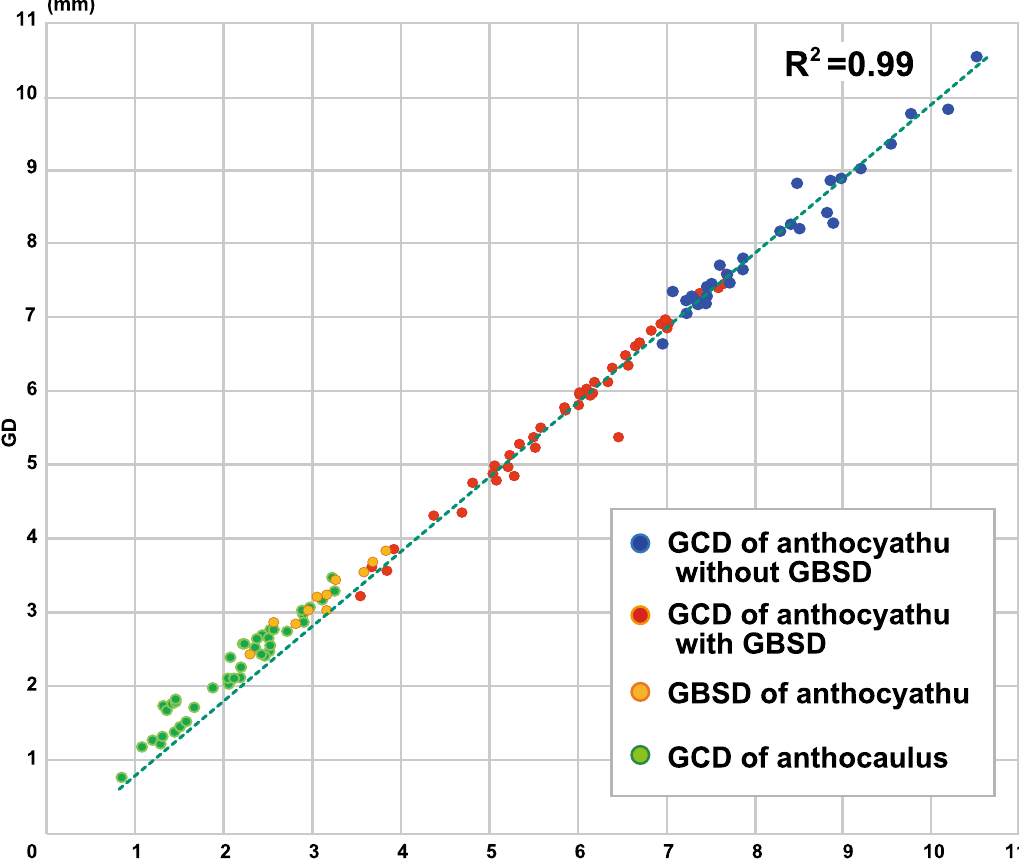
Figure 5. Relationship between the GCD/LCD of Anthocyathu without GBSD, GCD/LCD of Anthocyathu with GBSD, GBSD/LBSD of Anthocyathu and GCD/LCD of Anthocaulus (R2 = 0.99, N = anthocyathus without it (Fig. 3, Supplementary Table S1). In addition, Sentoku et al . 8 showed that D. orientalis is capable of self-repair if 10% of the skeleton remains after physical damage, in which the basal discoloration can potentially be lost. Therefore, discoloration restricted to the basal part of D. orientalis is inferred to be generated by decalcification, and almost all D. orientalis may inherently have a discolored basal part. In the attached specimens, white opaque discoloration lines on the outside of the wall perpendicular to the growth direction and double-walled structures, such as rejuvenescences, were observed (Fig. 4A–C). Anthocauli of Pliocene fossils of Truncatoflabellum carinatum and extant Truncatoflabellum spp. show successive rejuve- nescences that are derived from a temporal decrease in polyp diameter due to transverse division injury 14,15 . Moreover, the anthocauli of extant Truncatoflabellum spp. exhibit traces of decalcification at the uppermost periphery of the outer wall portion of the rejuvenescence. A similar trace of decalcification of anthocaulus has been reported in Fungia fungites 16 . The discoloration and double-walled structures in the attached specimens are thought to have been formed by transverse division with decalcification. Furthermore, the nucleotide sequences of the undescribed species and D. orientalis were completely consistent in the 16S-rDNA region (462 bp) and CO1 region (646 bp). In addition, due to the creation of phylogenetic trees using the nucleotide sequences obtained from the five gene regions, the undescribed species and D. orientalis were found to represent a single clade in all gene regions (Fig. 6A–B, Supplementary Fig. S1A–C). Based on the results of both the morphological and molecular phylogenetic analyses, we concluded that the undescribed species was the anthocaulus of D. orientalis . Moreover, the free-living anthocyathus of D. orientalis reproduces asexually by transverse division of the attached anthocaulus. Control of anthocyathus morphology by transverse division. Two calical morphologies were observed in the attached coralla: the depressed calice and the exerted and bulged calice with distinct costae (Fig. 4). Particularly, the skeletal characteristics of the uppermost part of the latter attached specimens were found to closely resemble those of the anthocyathus of D. orientalis (Fig. 4B). The smaller corallum of the antho- cyathus of D. orientalis shows a slightly protruding base with decalcification. The center of the basal part is composed of tubercular fragments from the divided columella of the anthocaulus and is encircled by costae.